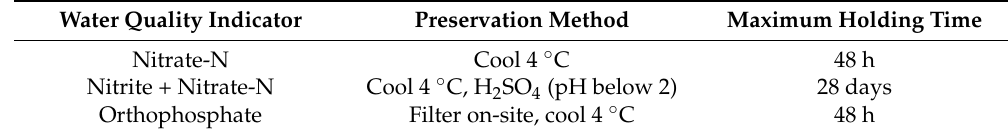
Table 1. United States Environmental Protection Agency (US EPA) water sample preservation methods